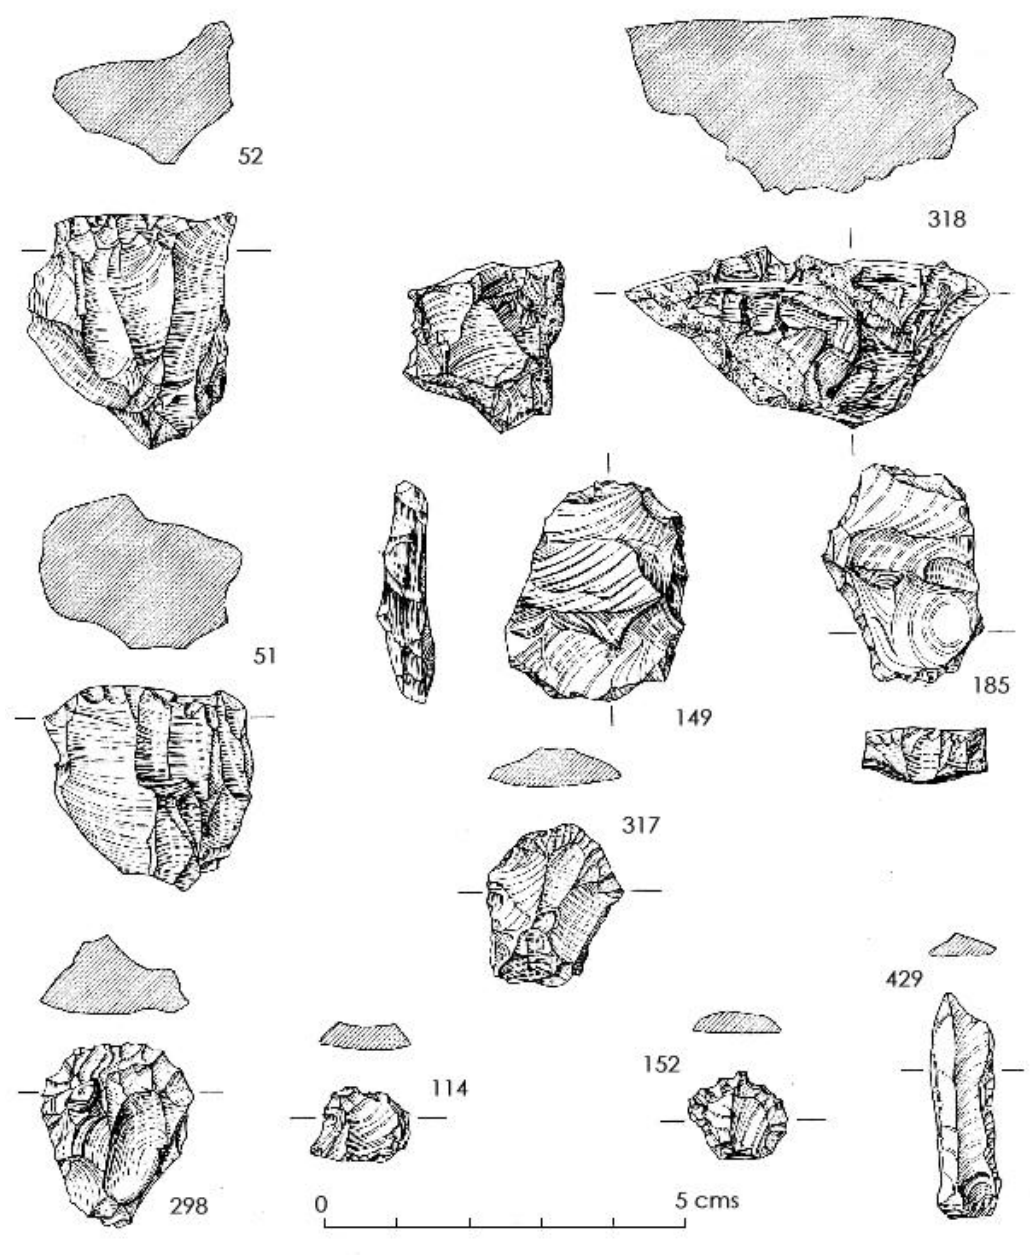
Figure 7: The lithic assemblage: 51, 52 & 318 cores; 149 & 185 core tablet scrapers; 114, 152 & 317 end scrapers; 152 thumbnail scraper; 429 edge retouched